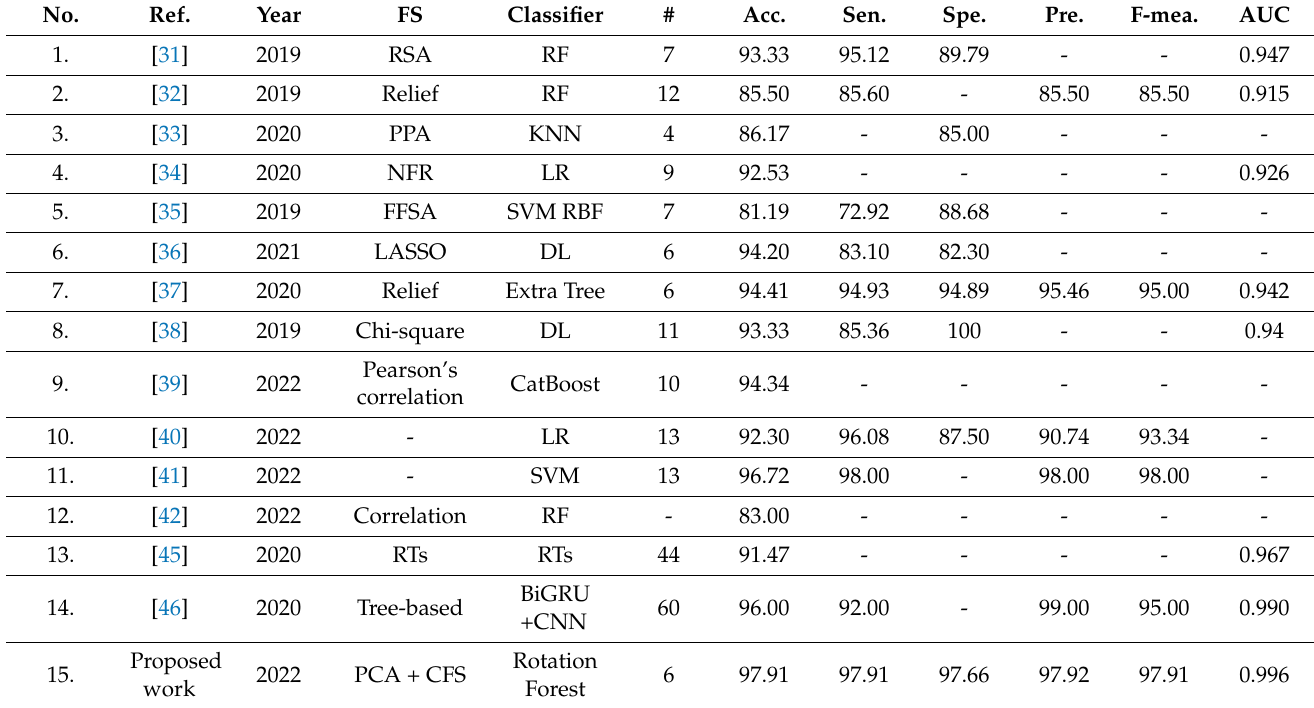
Table 16. Performance comparison of related works.